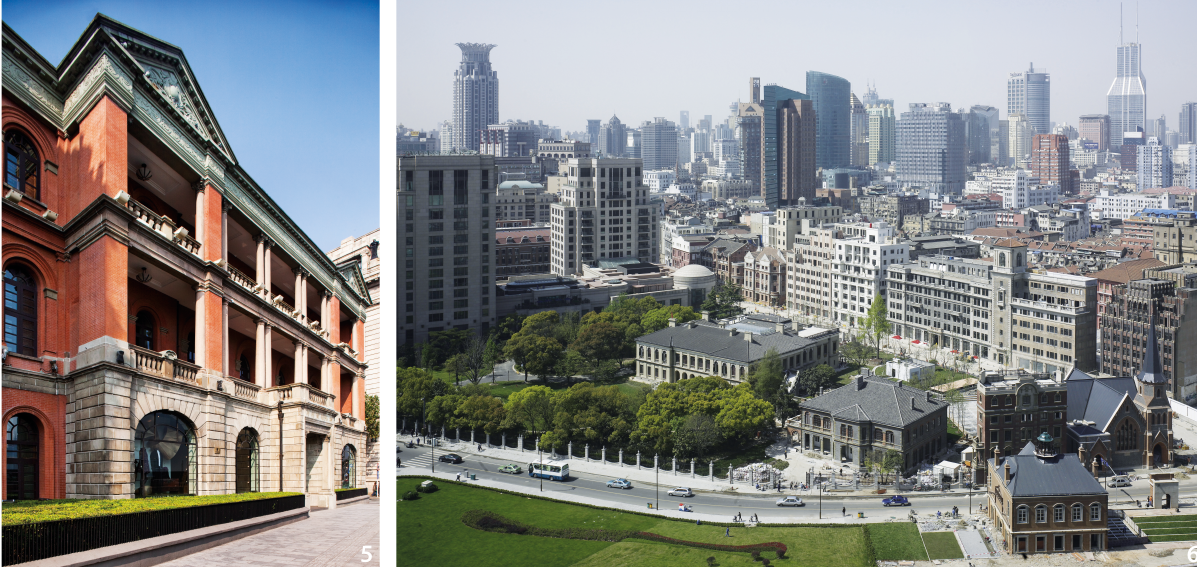
Figure 5 The former China Merchants Steamship Navigation Building after restoration (Source: Photograph by Xu Zhigang). Figure 6 Bird view of Waitanyuan (the north end of the Historic Bund) after renovation (Source: Institute of Shanghai Architectural Design and Research Co.,